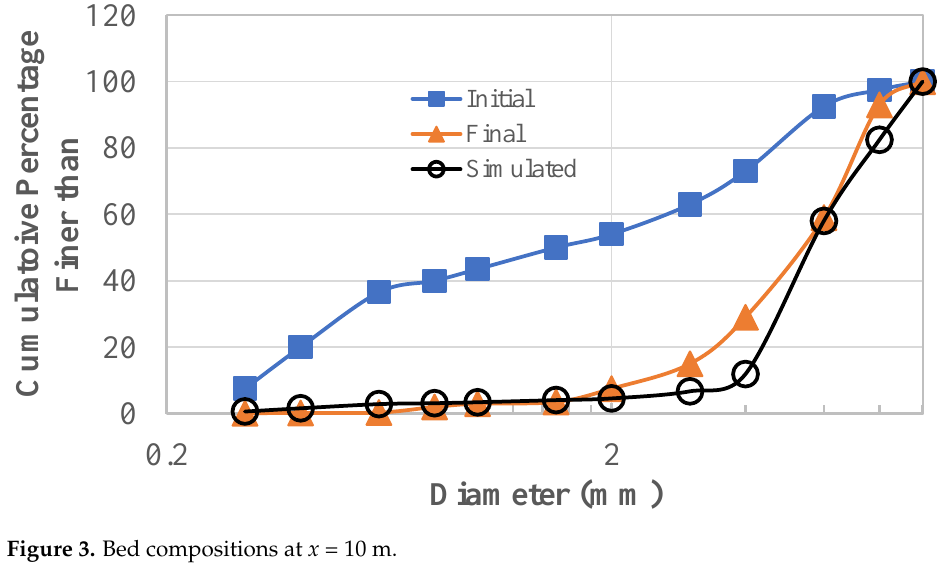
Figure 3. Bed compositions at x = 10 m.